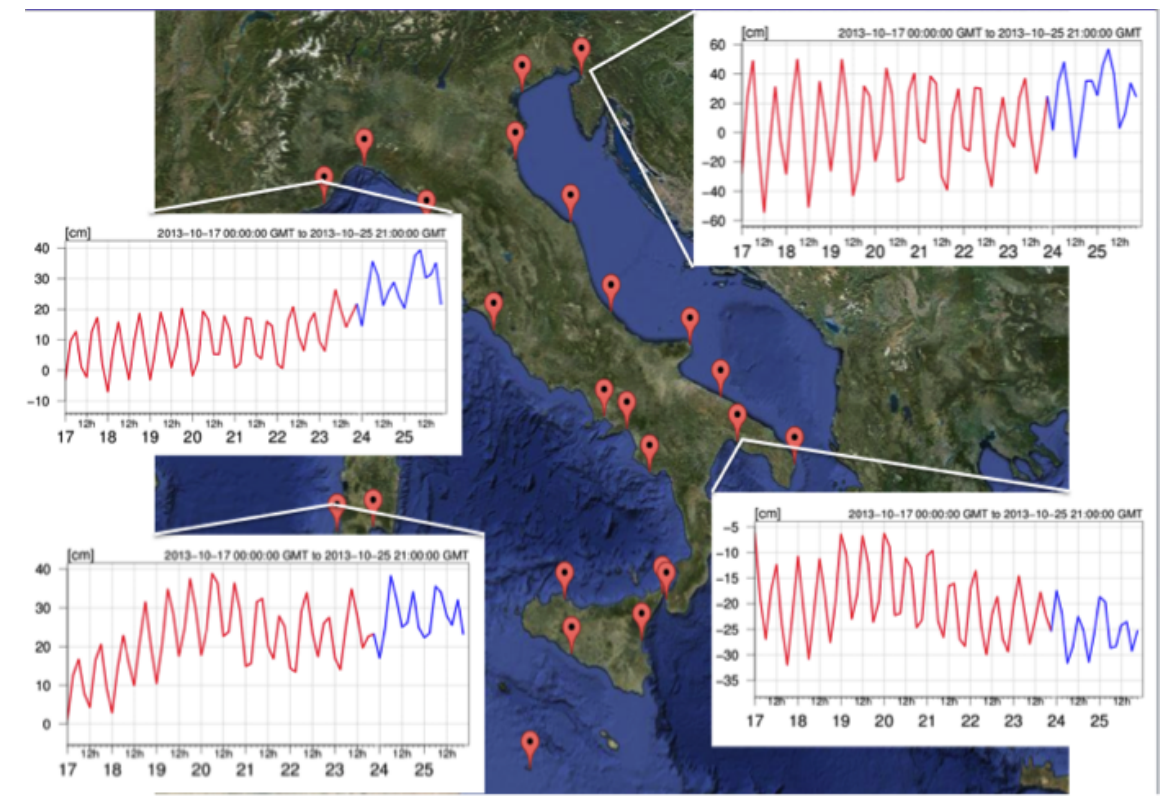
Figure 4. Examples of SeaConditions sea level products in four different locations along the Italian coasts showing the time series of sea level observations in red, and the forecasts for the sea level over the next 2 days in